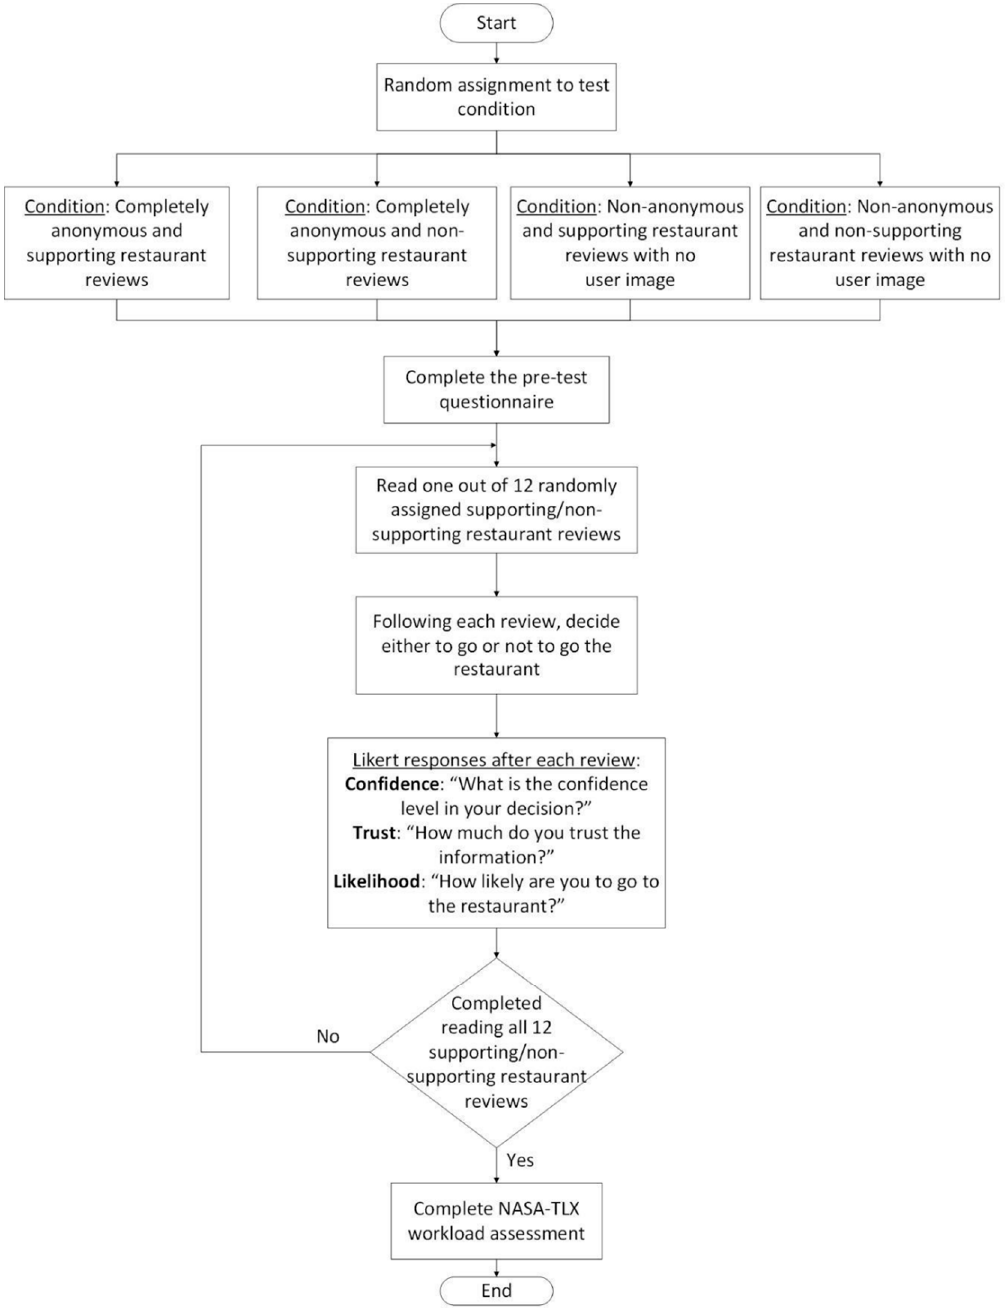
Figure 5. Flow chart outlining study procedure.